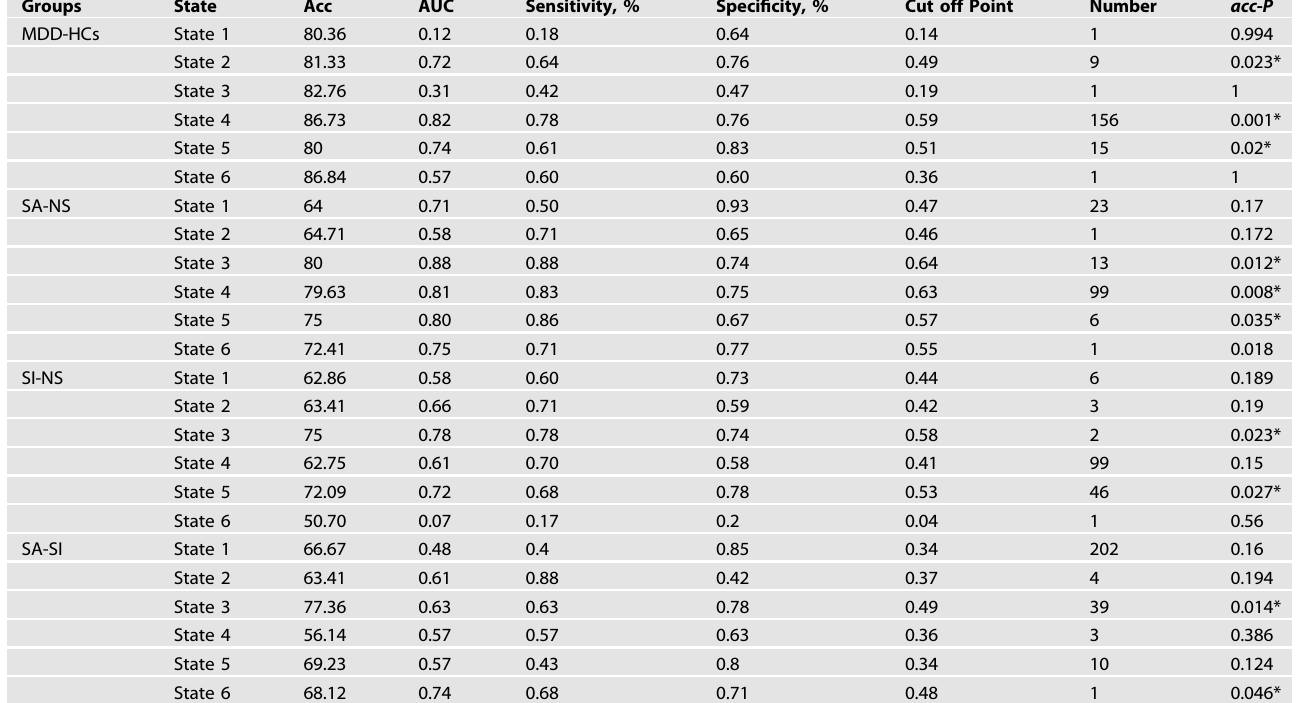
Table 3. Classi fi cation performance for linear SVM in each state between MDD and HCs and among MDD subgroups. Groups